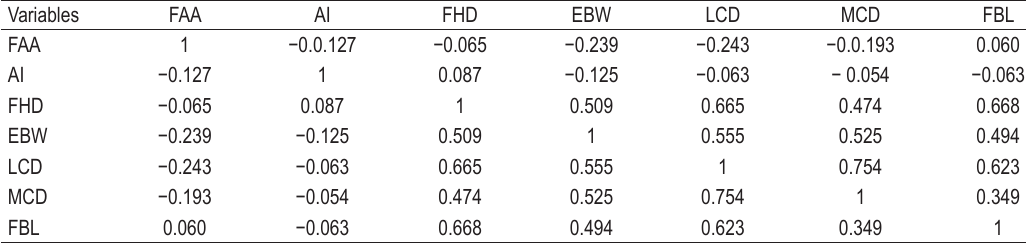
TABLE 4. Correlation matrix for male